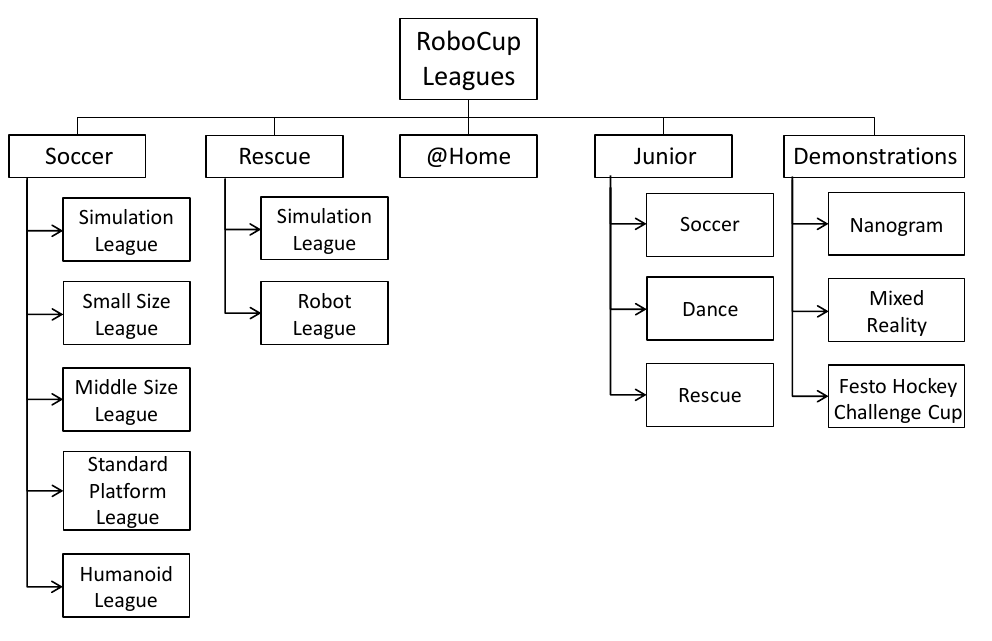
Figure 1: RoboCup Soccer